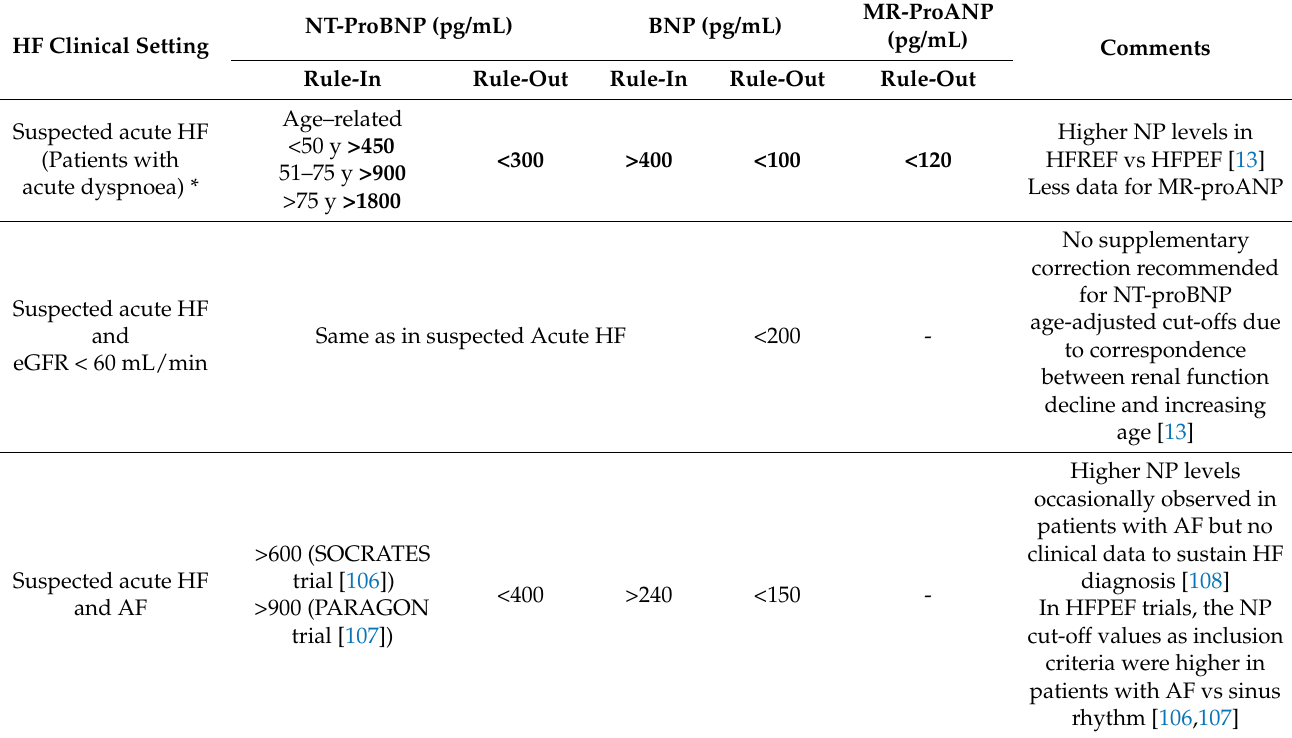
Table 2. Natriuretic peptides cut-off values in different heart failure